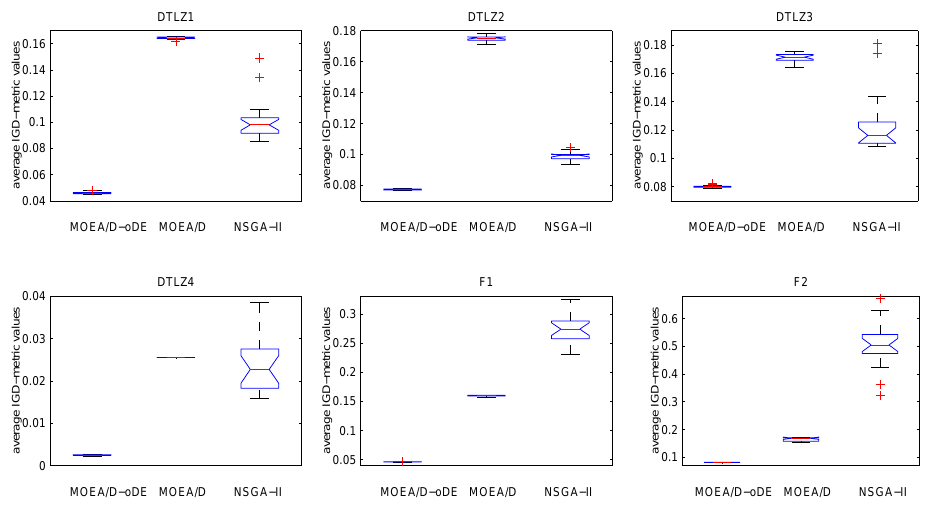
Figure 7. Box plots of the IGD metric values based on 20 independent runs for five-objective test problems.